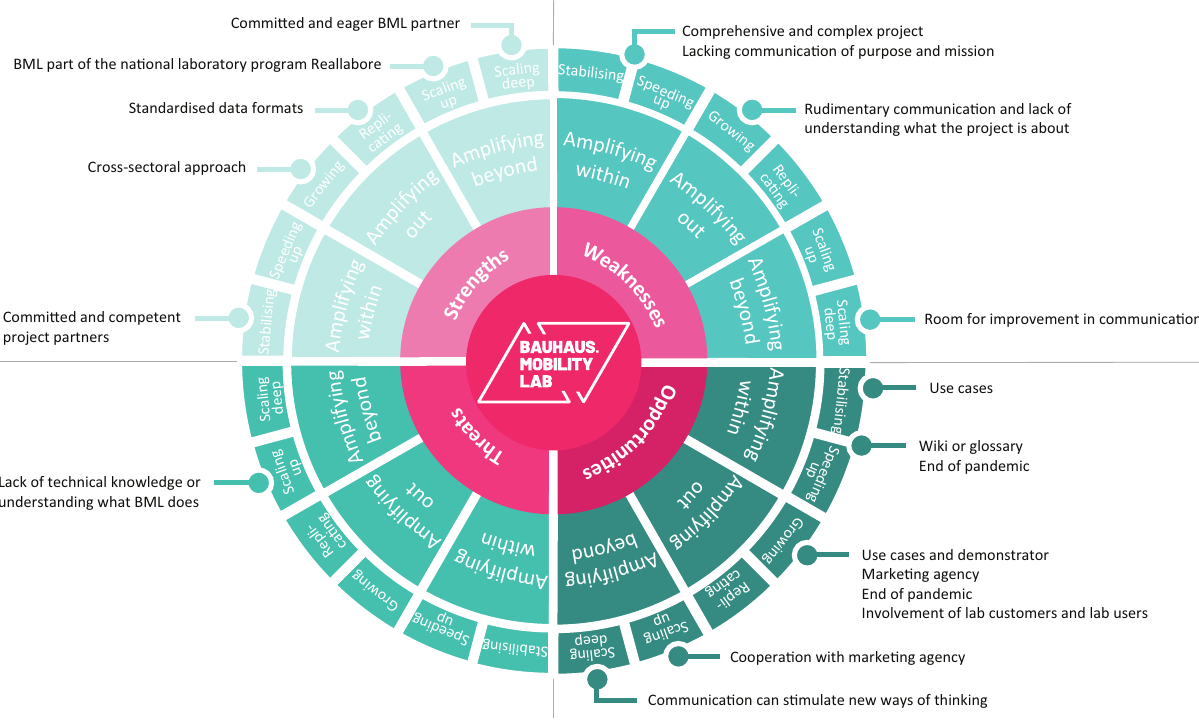
Figure 2. Repeatedly mentioned and common denominators of amplification processes in the BML according to Lam et al.’s (2020) “typology of amplification processes.” Identified processes were assigned to